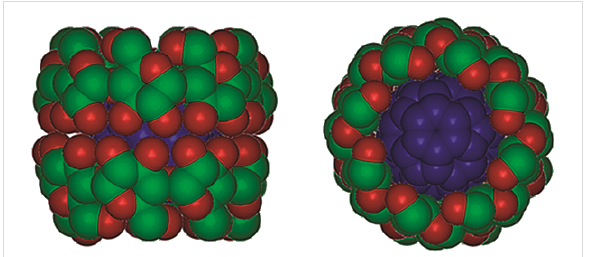
Figure 1: Space-filling model of the most stable complex between γ -CD and C 60 with 1:2 stoichiometry, calculated in vacuo. Reprinted with permission from reference [29]. Copyright (2010) American Chem- ical